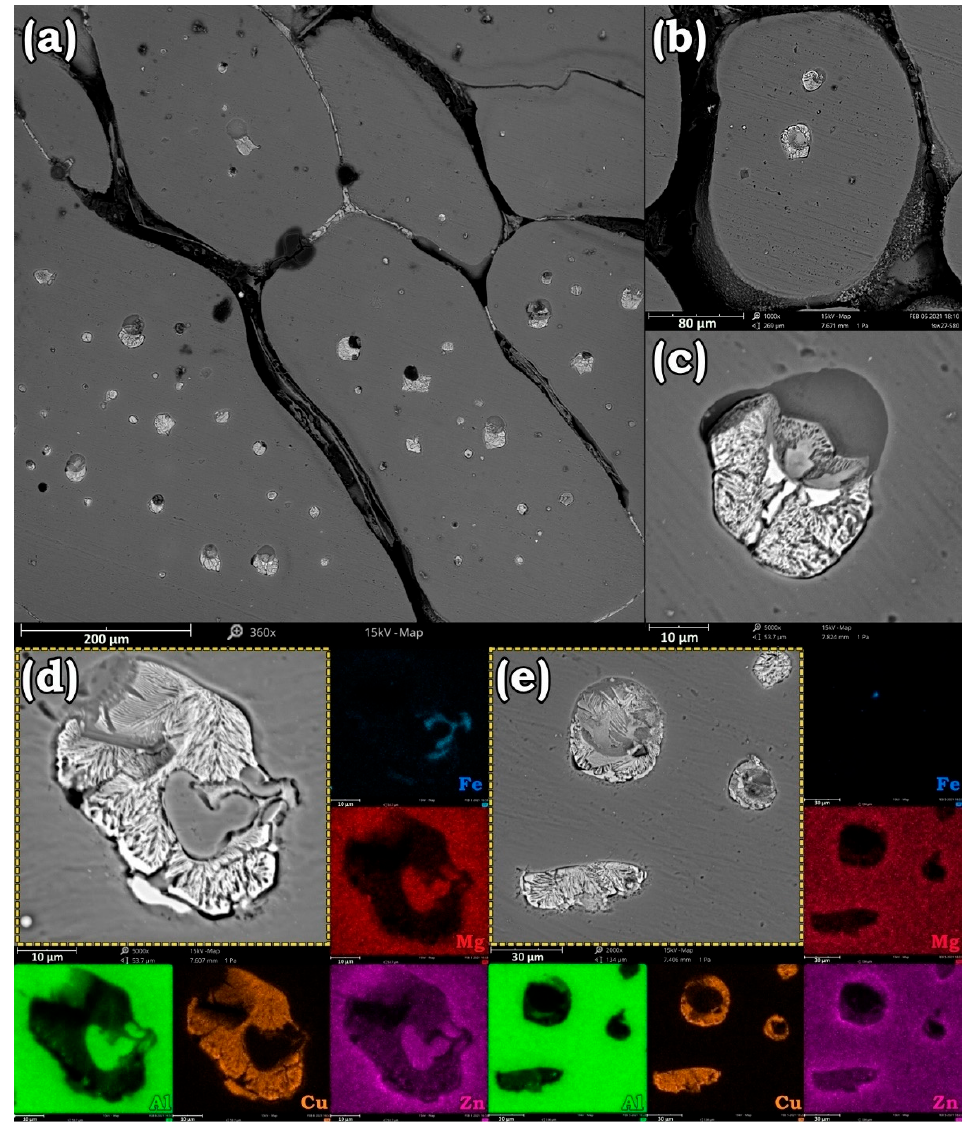
Figure 6. Distribution of intermetallic phases ( a ), the formation of island-like Cu-rich eutectic phases at the center of the grains ( b , c ), and element distribution map of them ( d , e ) in the stir zone (SZ) of AA7475 after solution treatment at 580 °C for 1 h.